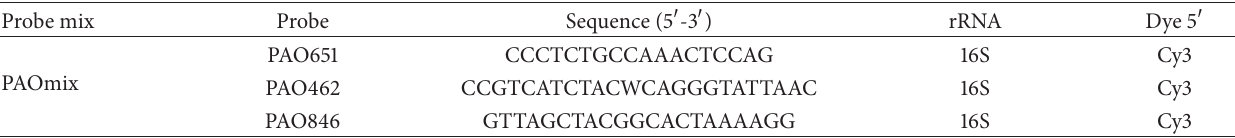
Figure 1: A two-sludge denitrifying phosphorus removal and induced crystallization process. Table 2: FISH probes used in this